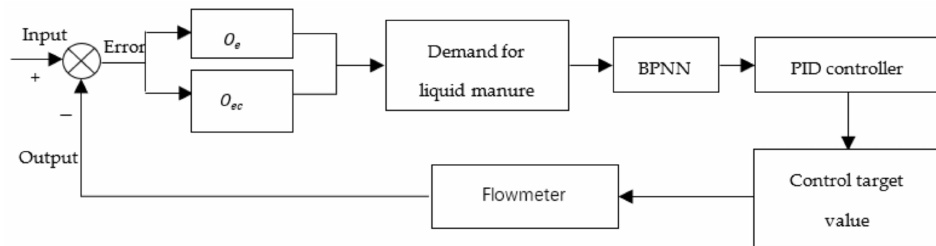
Figure 6. Control schematic diagram of BPNN–PID